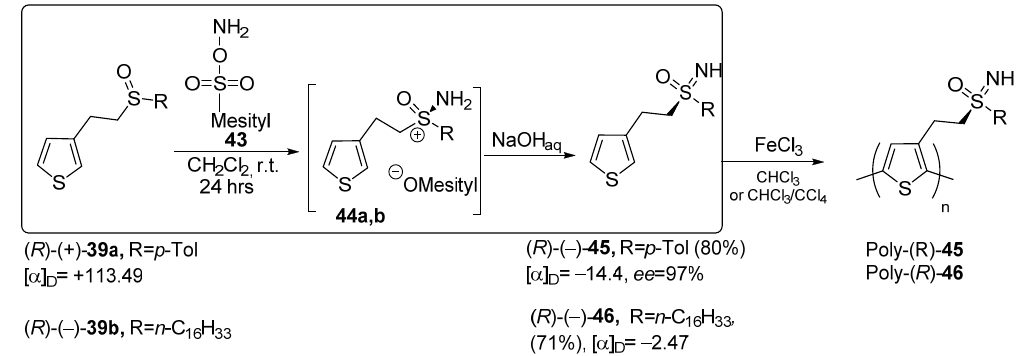
Scheme 12. The preparation of 2- (3 (cid:48) -thienyl)ethyl p -tolyl( n -hexadecyl) sulfoximines by an imination with MSH and the subsequent